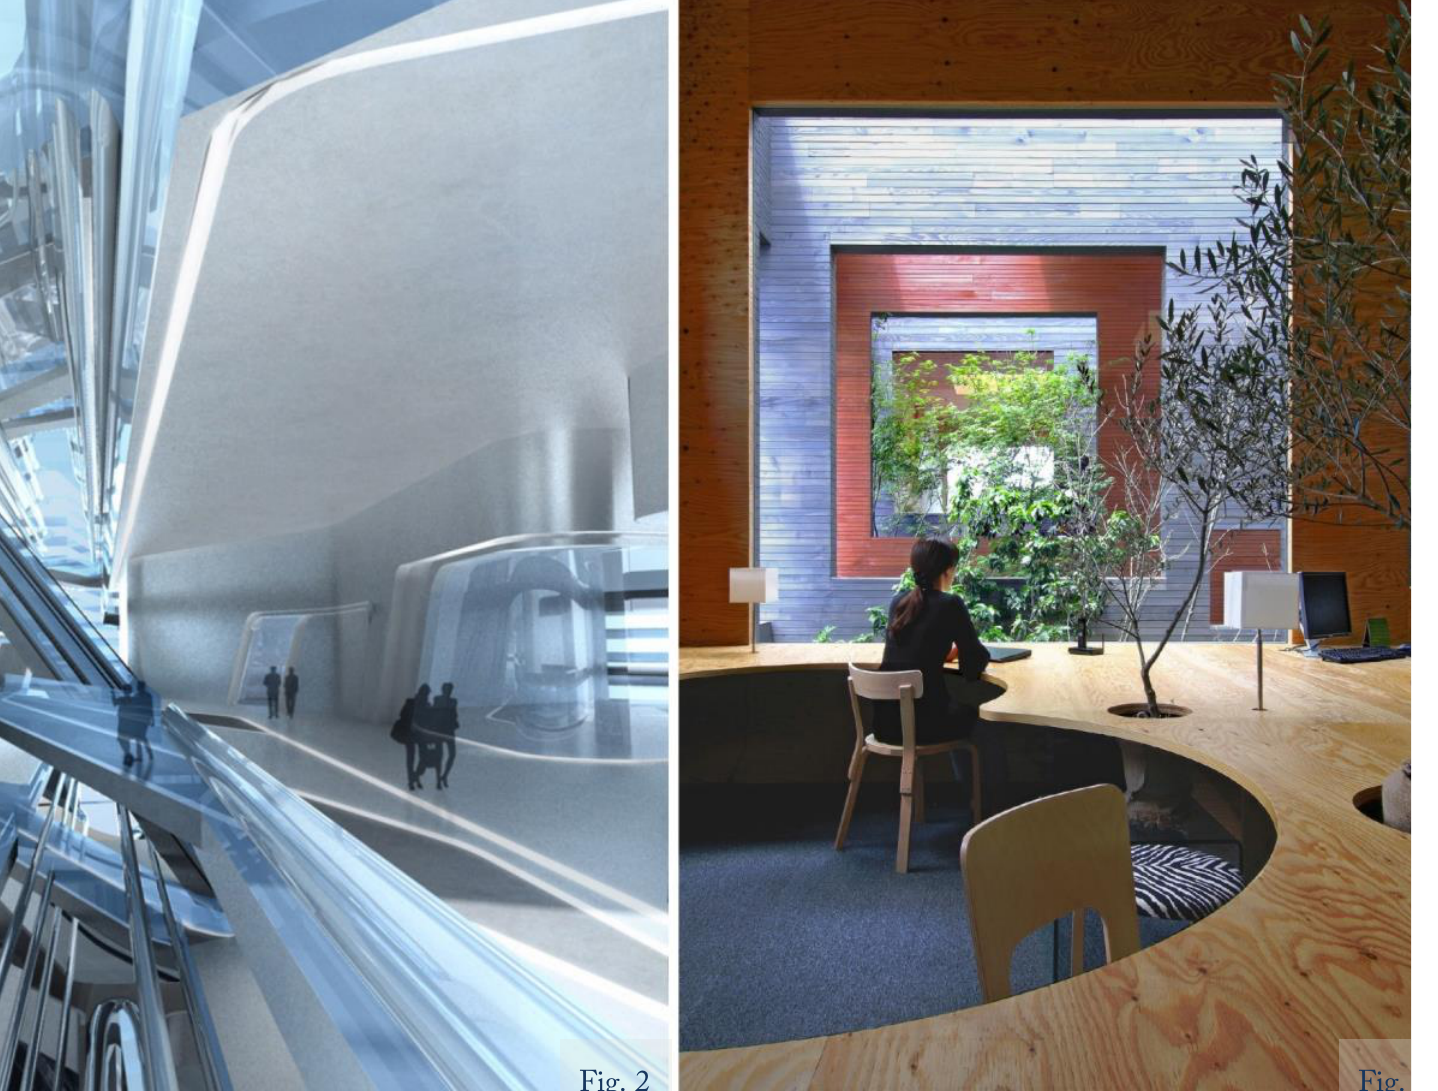
Figure 2. Hong Kong Polytechnic University’s “Innovation Tower” (Unknown, 2011). From: http://goo.gl/OXsWQl. Figure 3. Mori x Hako by UID Architects (Ueda, 2012). From: